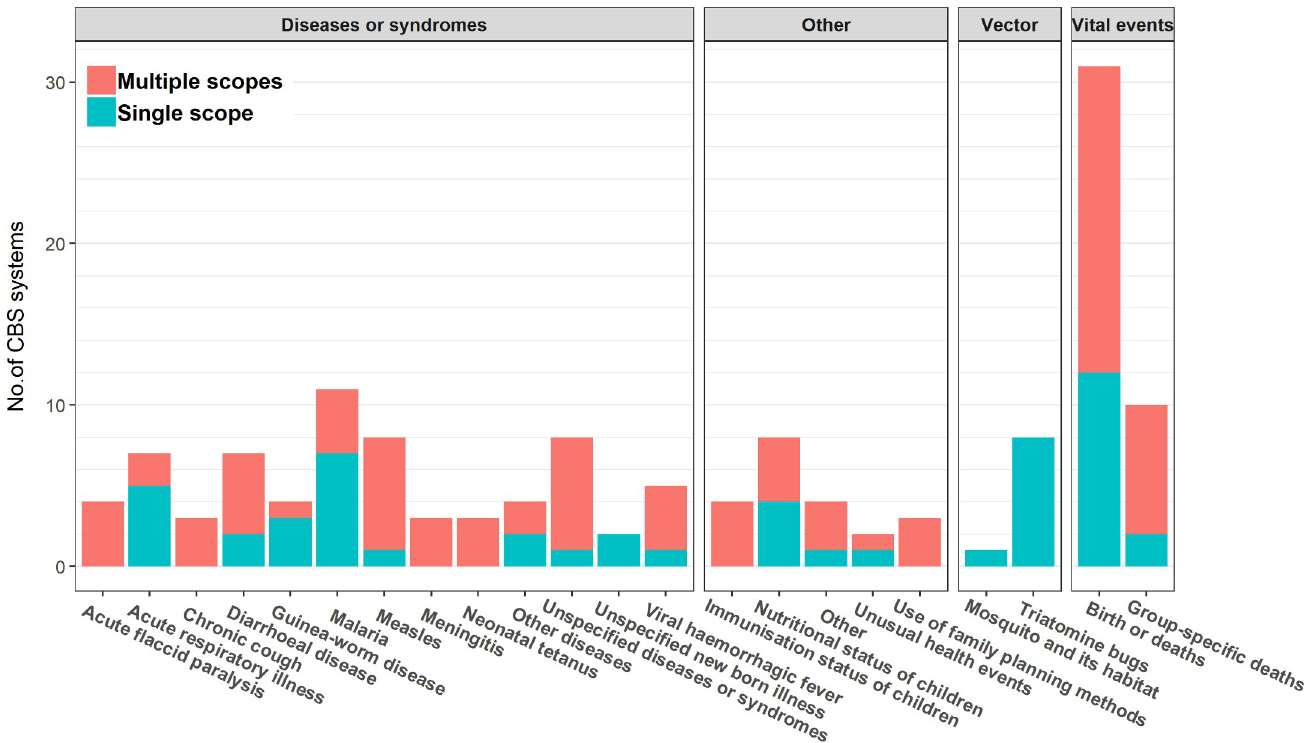
Fig 4. Distribution of CBS systems by scopes of interest (n = 79 systems). a includes influenza like illness and avian influenza; b includes cholera, acute gastrointestinal illnesses; c includes Buruli ulcer (n = 1), cutaneous leishmaniasis (n = 1), yaws (n = 1), smallpox (n = 1); d includes Ebola virus disease and dengue; e includes pregnancy complications (n = 2), low birth weight (n = 1), suicidal and self-injurious behaviour (n = 1); f includes maternal, neonatal, infant, under-five